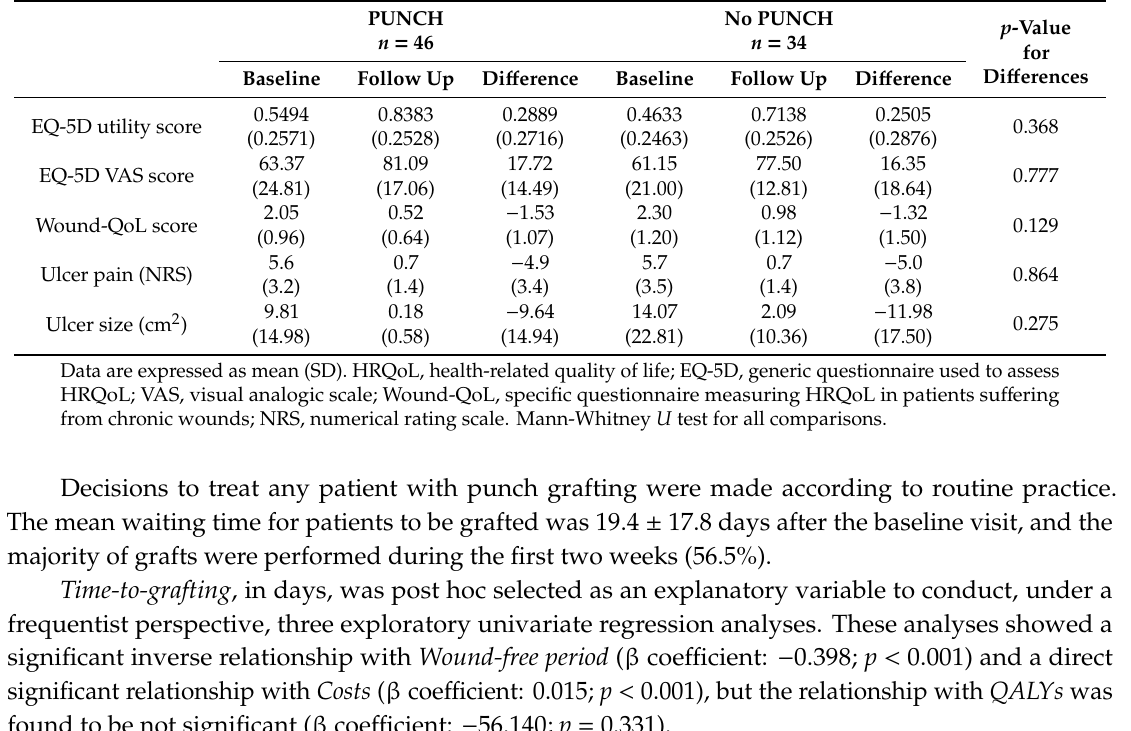
Table 3. Comparison of change from baseline in HRQoL and ulcer pain and size.